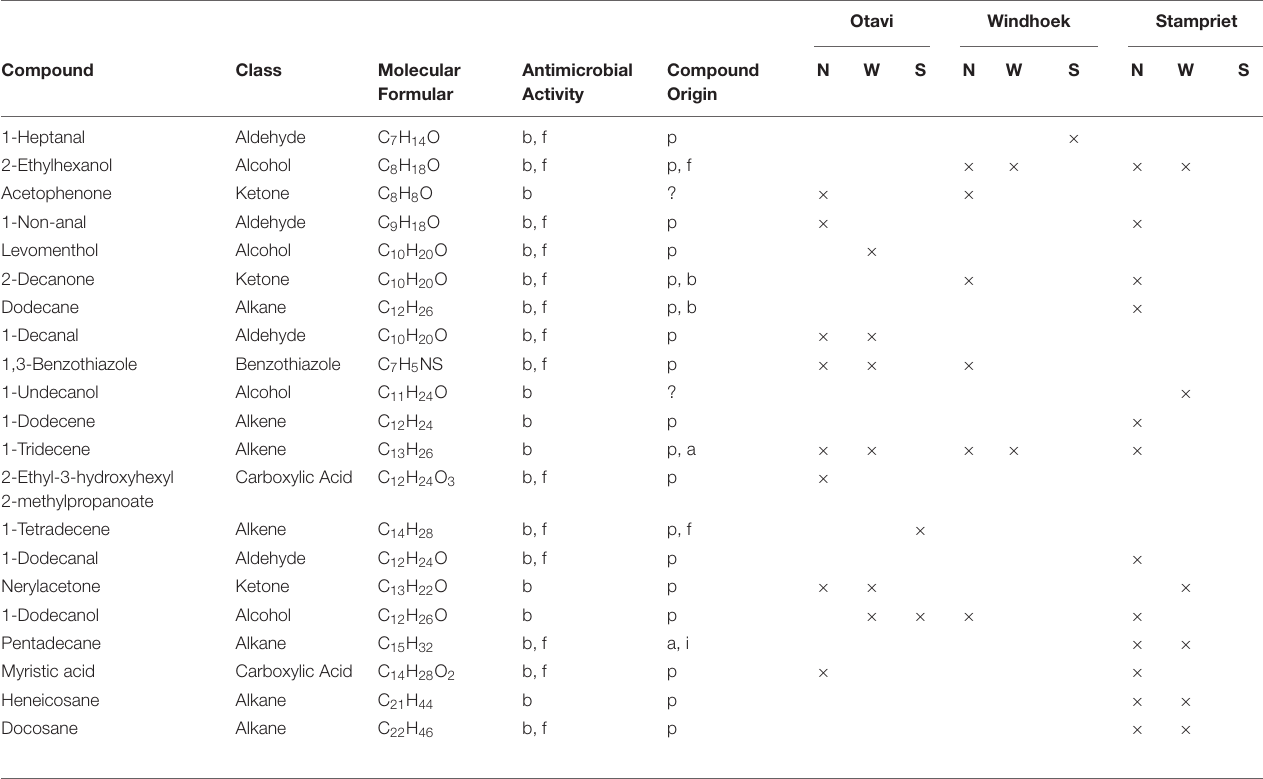
TABLE 1 | List of identified compounds in the nest (N), web (W), and spider (S) volatilomes of the different sampling sites Otavi, Windhoek, and Stampriet with known antimicrobial activity.